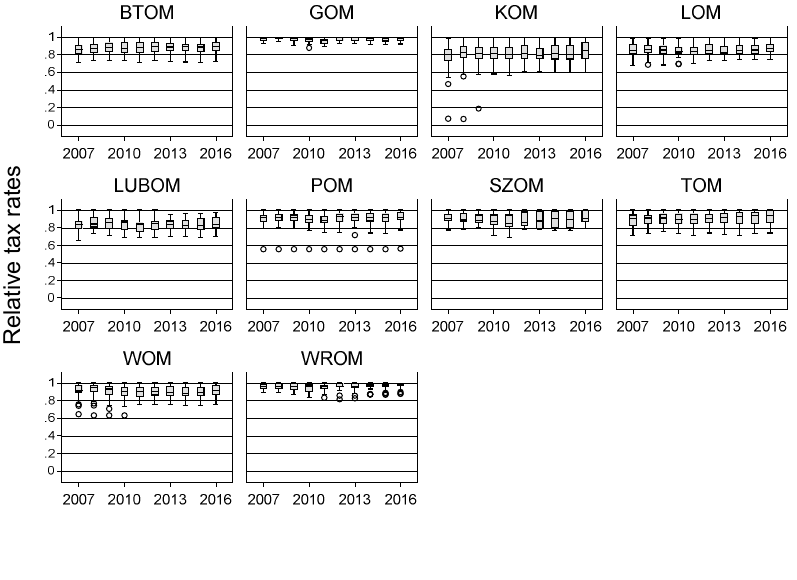
Figure 2. The tax rate on buildings used for business purpose from 2007 to 2016 (relative to Maximum Rate set by Ministry of Finance, in